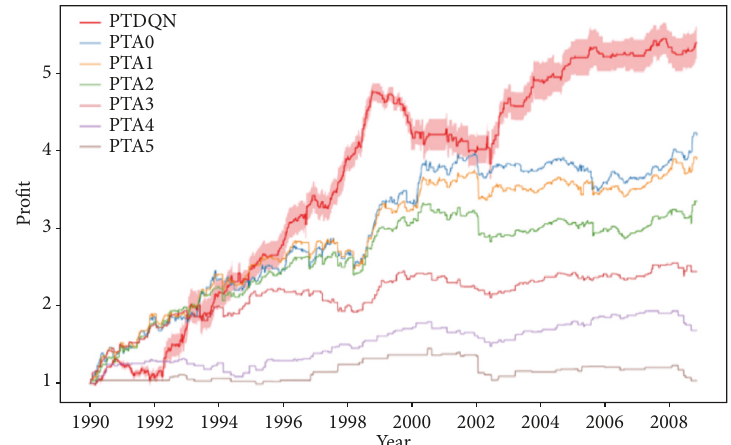
Figure 9: Average top-5 profits generated by PTDQN and traditional pairs-trading strategies using TLS in training